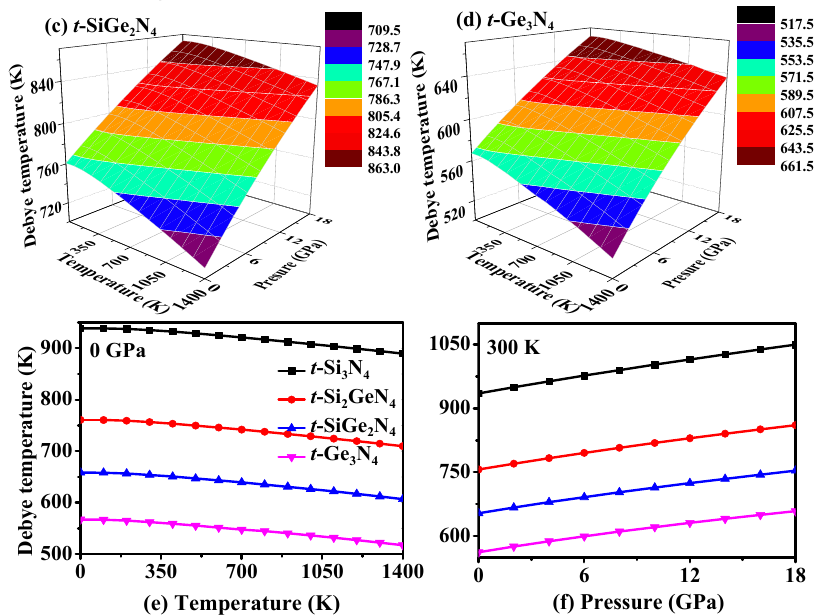
Figure 10. ( a – d ) Three-dimensional contour plots of the Debye temperature versus pressure and temperature for t -Si 3 N 4 ( a ); t -Si 2 GeN 4 ( b ); t -SiGe 2 N 4 ( c ); and t -Ge 3 N 4 ( d ). The Debye temperature as functions of temperature ( e ) and pressure ( f ) for t -Si 3 N 4 , t -Si 2 GeN 4 , t -SiGe 2 N 4 , and t -Ge 3 N 4 .